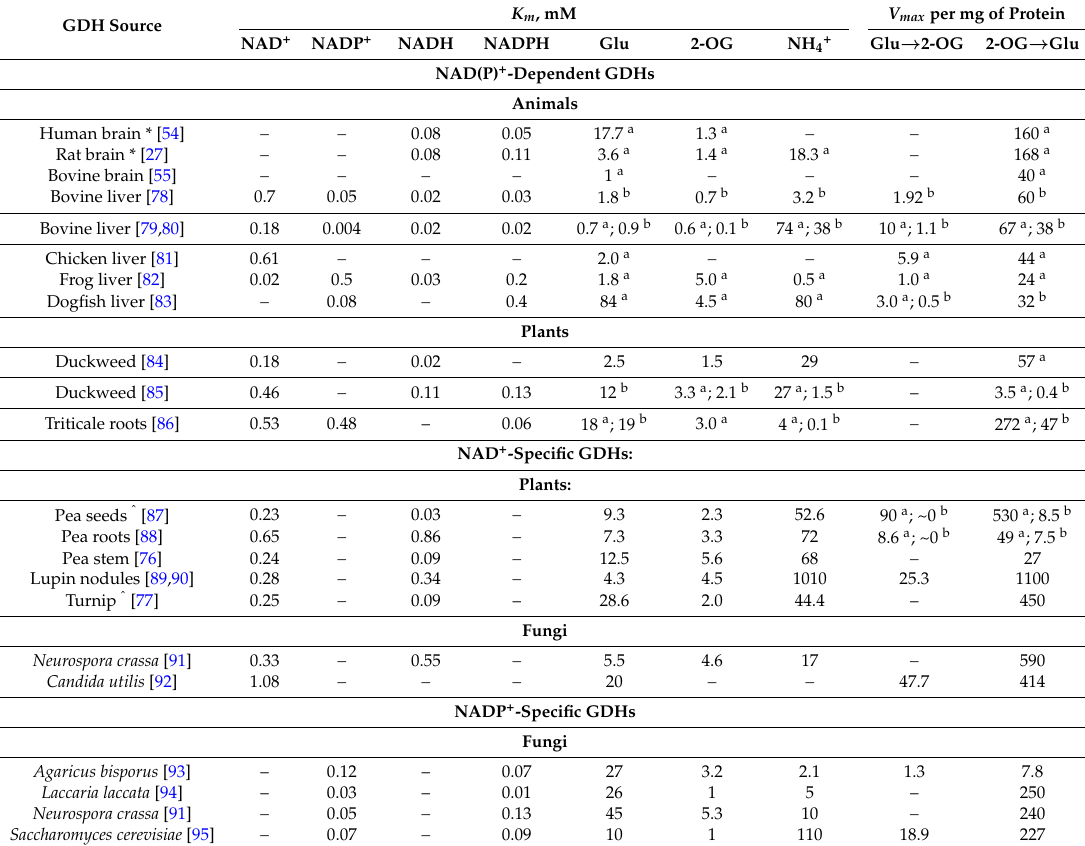
Table 1. Kinetic parameters of purified GDHs of animal origin in comparison to those of other higher eukaryotes. Michaelis constants K m and specific maximal activities, corresponding to Vmax per mg of protein ( µ mol/min per mg of protein) were measured at optimal pH values in the forward (Glu → 2-OG) and backward (2-OG → Glu) GDH reactions. Glu—glutamate, 2-OG—2-oxoglutarate. GDHs were purified from total homogenate, except for GDH from pea stem [76] and turnip [77], which were purified from the mitochondrial fraction. Superscripts indicate the following variations in the assay conditions: a —NAD(H)-dependent reaction; b —NADP(H)-dependent reaction; *—1 mM ADP